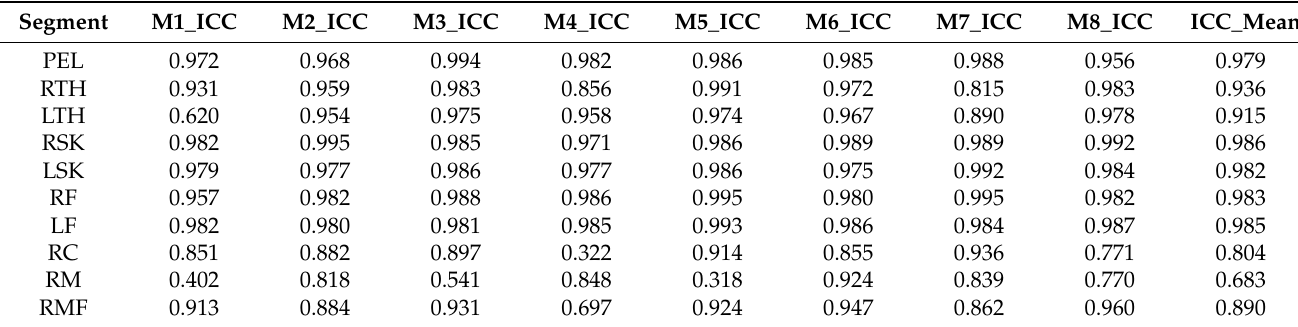
Table 3. Reliability of lower limb segments length. Mean intraclass correlation computed from all records of each segment by eight evaluators (M1–M8). ICC_mean was calculated from eight evaluators.